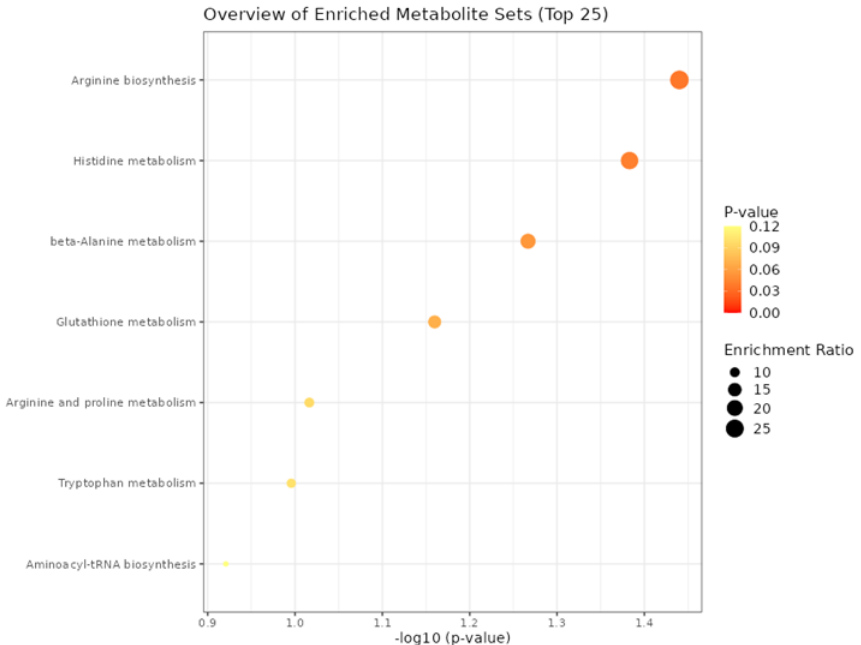
Figure 4. Top biological processes involved with significant blood plasma metabolites of bulls in the rearing phase from the three different maternal treatments (NP, PP, and FP).